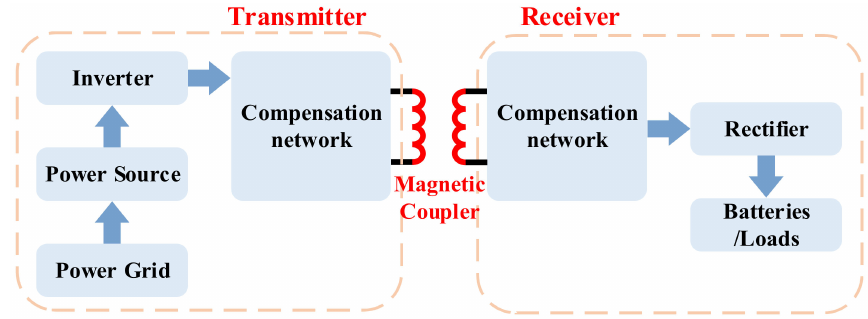
Figure 6. Components and fundamentals of the MCR-WPT